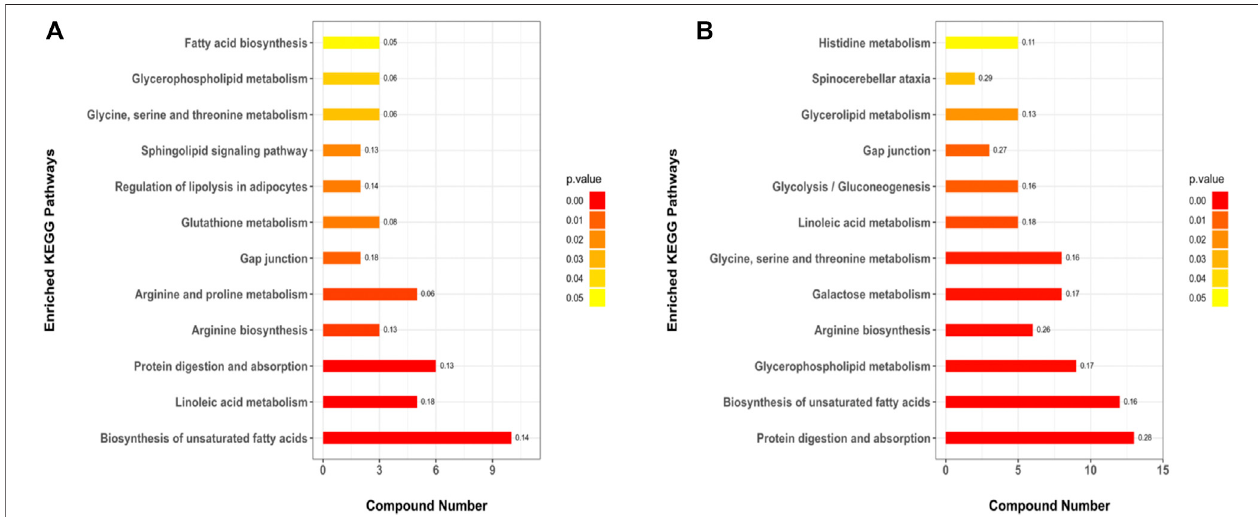
FIGURE 8 | KEGG pathways of the DEMs. (A) : BC and MC groups, (B) : MC and CPT groups. The x -axis represents protein number, the y -axis represents the KEGG pathway and the numbers represent the enrichment factor ratio of DEMs.